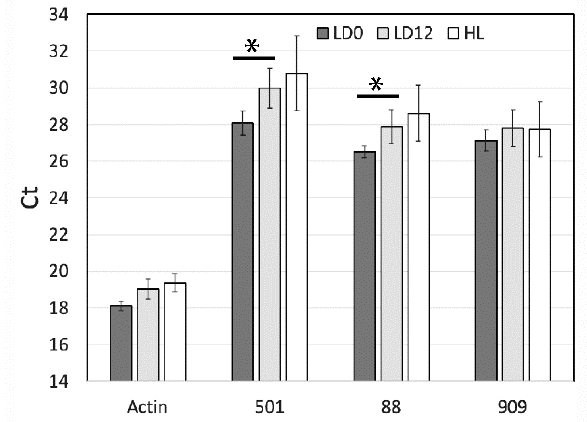
Figure 4. qPCR analysis of 3 selected light-regulated genes from RNA sequencing analysis. Ct values were obtained for three RNA-Seq predicted regulated genes (501, SymkaALLUN13501; 88, SymkaALLUN19088; 909, SymkaALLUN64909) as well as Actin as a control for the amount of cDNA. Triplicate samples from each of three biological replicates were averaged for LD 0 (samples were in the dark for 12 h), LD 12 (samples were in the light for 12 h), and for samples kept under constant high light for 24 h. Comparisons marked with * are significant at p < 0.01 using student’s t -test, respectively.